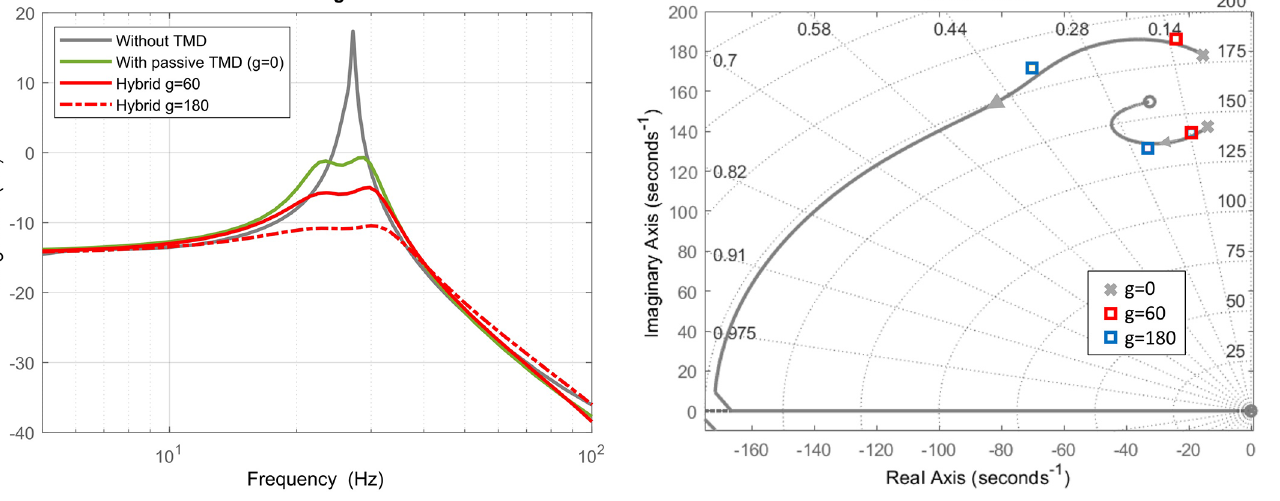
Fig. 10. Frequency response function in term of displacements without TMD (grey line), with passive TMD (green line) and with the HSHMD using different gains in red (Continuous line: g = 60 , dotted line: g = 180 ).